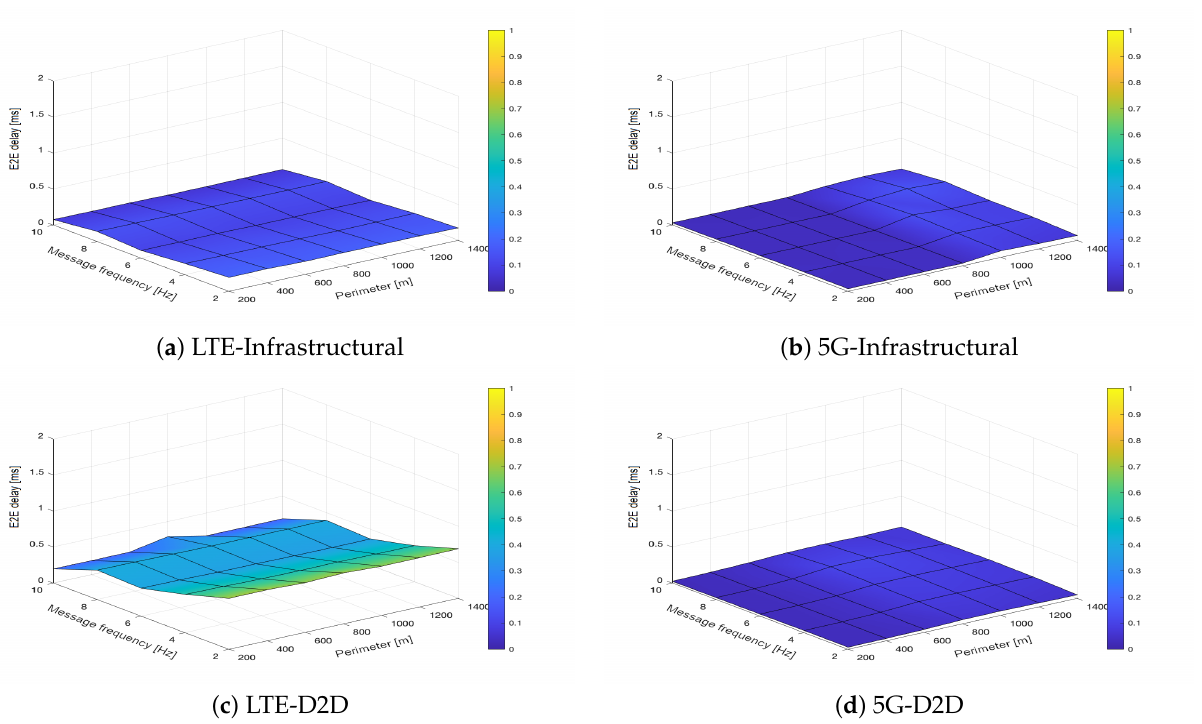
Figure 12. E2E latency simulated for all the investigated modes of the 4G-based and 5G-based C-V2X technologies and traffic intensity of 1250 vehicles per